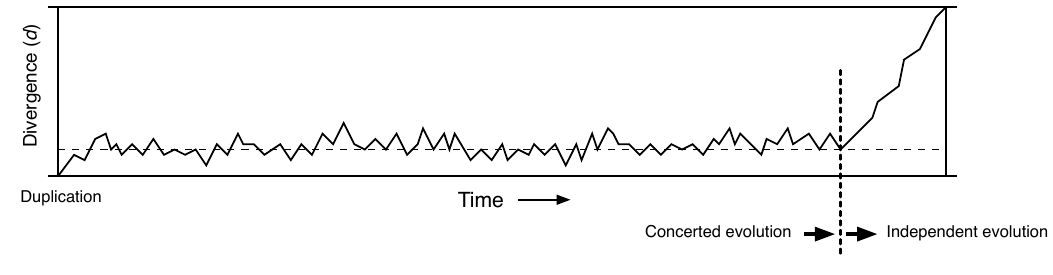
Figure 3. Typical behavior of the paralogous divergence d since the duplication event.